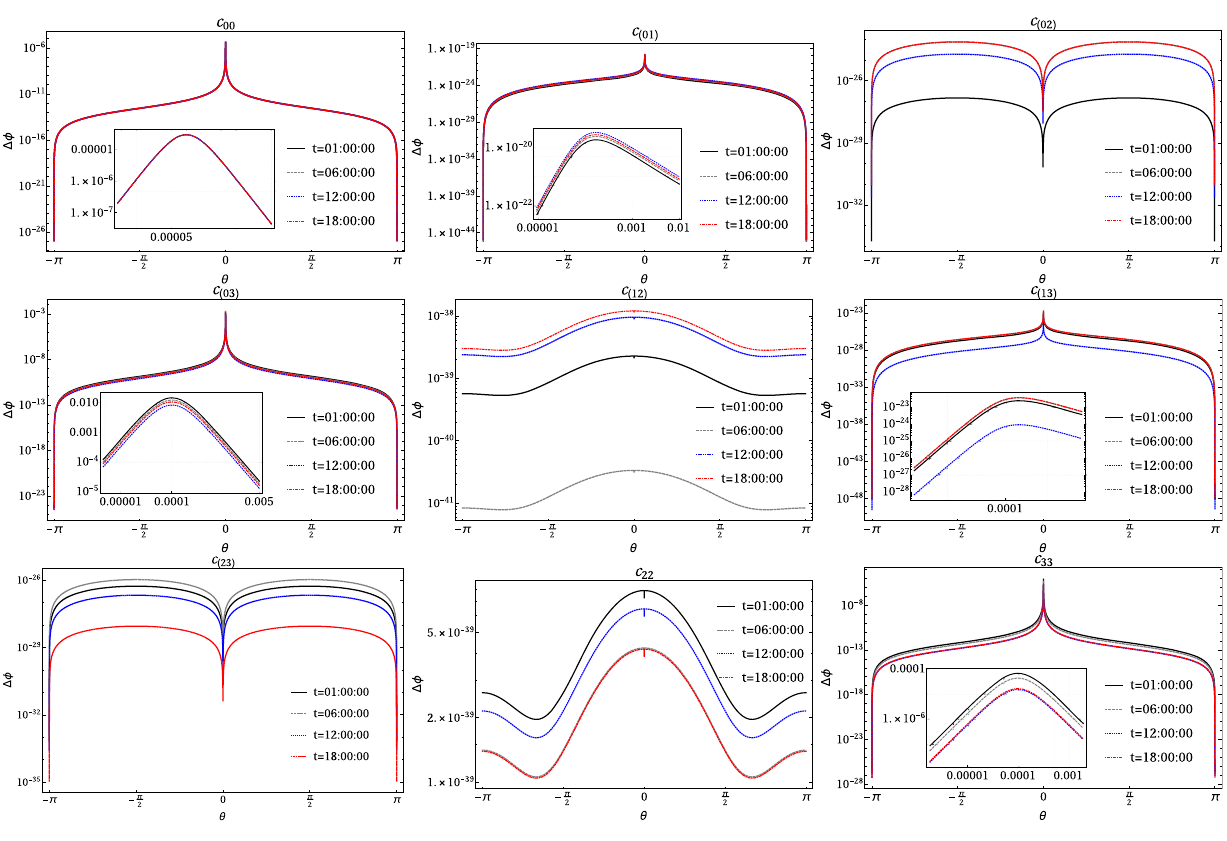
Fig. 3 FC phase, (cid:2)φ | LV μ as a function of scattering angle θ for four different times in a day–night. We have taken ϕ = χ = π